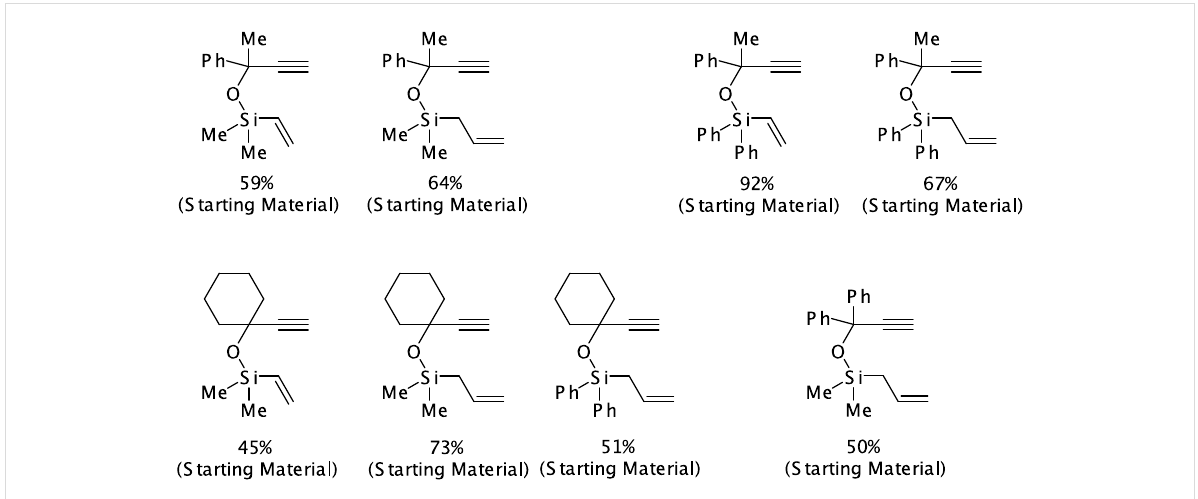
Figure 2: Chain-functionalised acetylenes prepared and used in silyl ether-tethered Pauson-Khand reactions. Yields correspond to yield of the silyl ether formed, figures in brackets the product recovered from the Pauson-Khand